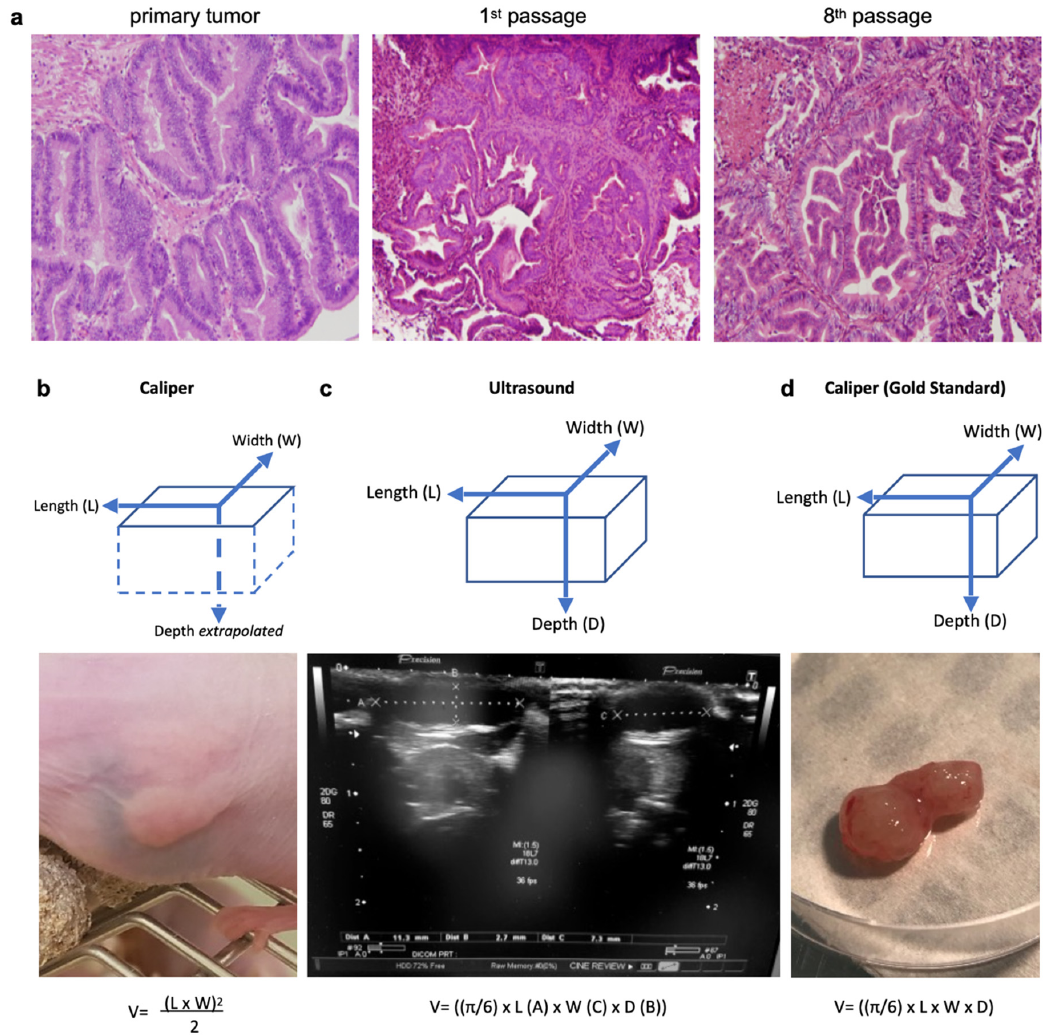
Figure 1. Three measurement techniques on primary gastric adenocarcinoma tumors grown in nude mice (PDX): caliper and ultrasound on living mice, and caliper on ex vivo tumors (gold standard). ( a ) Histological hematoxylin eosin staining (magnification 40×) of the primary human tumor compared to tumors issued from it grown in a PDX mouse (1st and 8th passage). The PDX tumors retained the major architectural and histological traits of the primary tumor and maintained across passages from mouse-to-mouse. ( b ) The caliper on the live mouse only measured the length and width, and the depth was estimated from the width. ( c ) An ultrasound enabled the measurement of all three dimensions of the tumor (length, width, and depth). ( d ) The caliper on the ex vivo tumor was the gold standard for length, width, and depth measures. Formulas used for tumor volumes are indicated below.